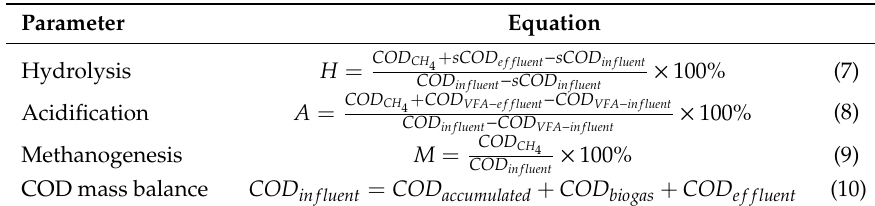
Table 8. Equations for metabolic ratios